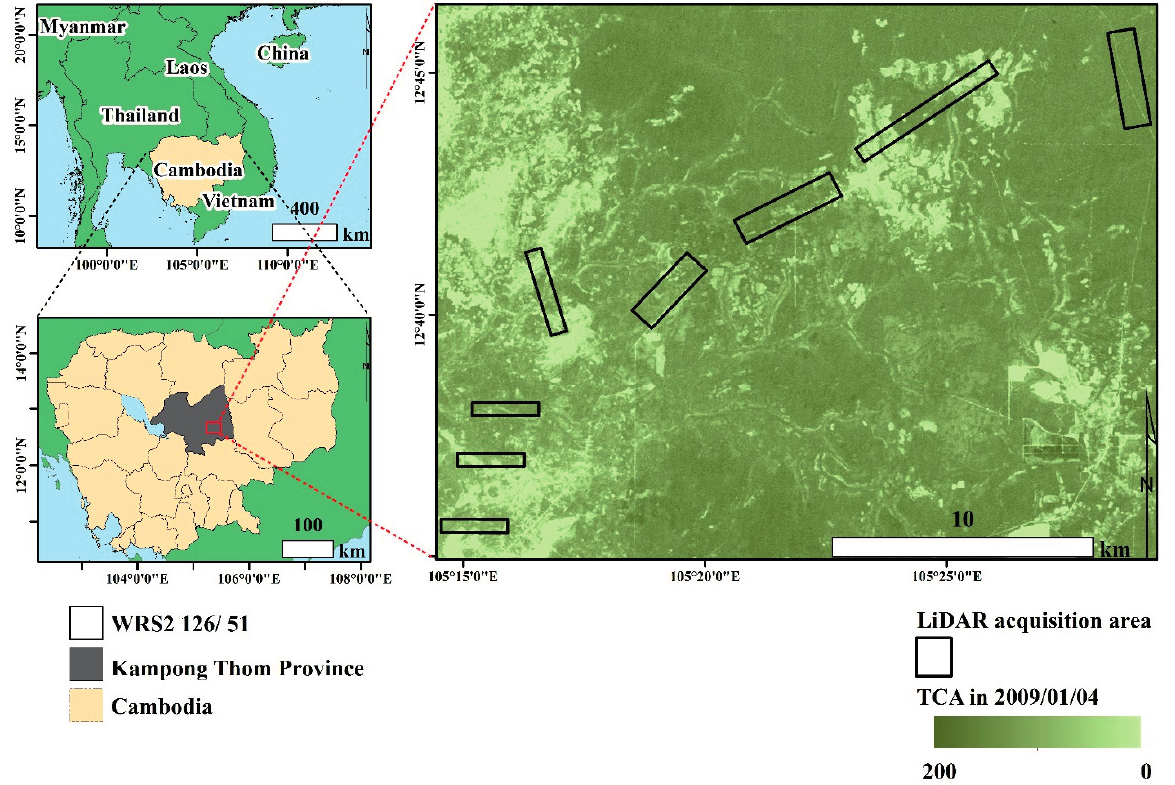
Figure 1. The study area located in Kampong Thom Province, Cambodia and the location of LiDAR data